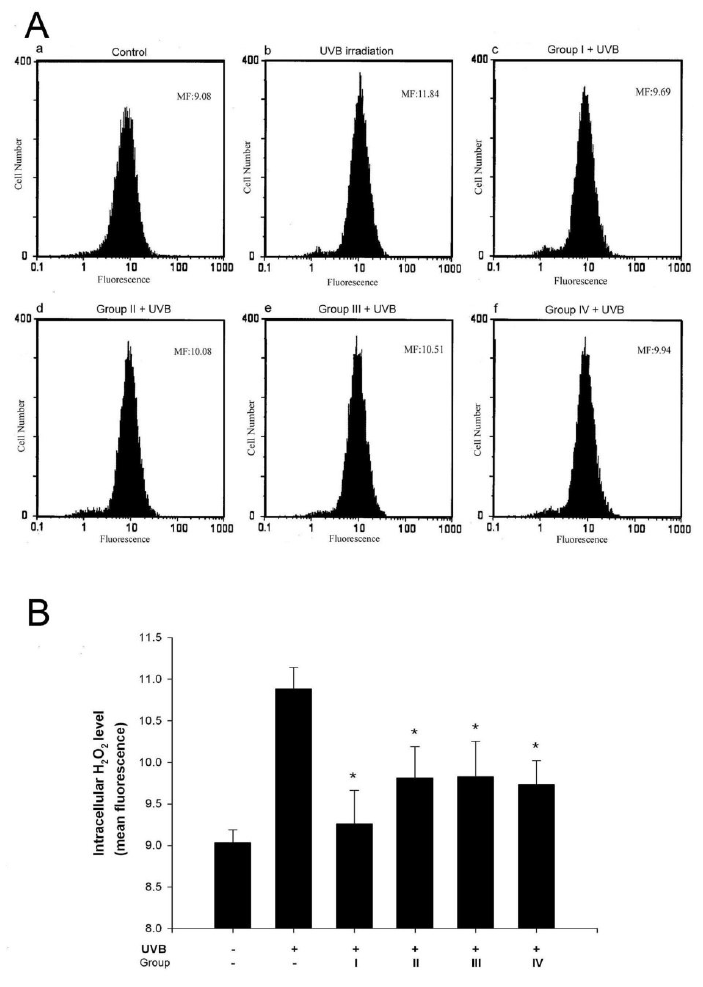
Figure 2. Group I~IV isoflavone extracts inhibited UVB irradiation-induced intracellular H production in human keratinocytes. (A) Intracellular H (MF)] was expressed as histogram and (B) the results from four independent experiments was analyzed. * P < 0.05 vs. UVB-exposed cells without isoflavone